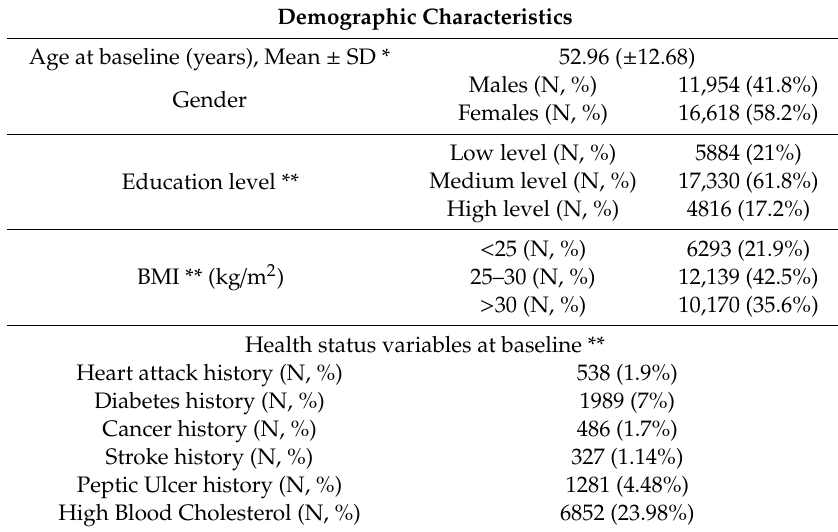
Table 2. Baseline characteristics of the participants of the EPIC-Greece study for the explanatory variables of interest.